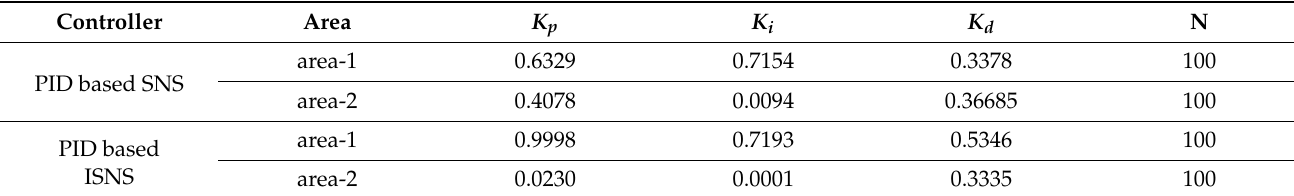
Table 2. The optimal parameters of the PID controller based on SNS and ISNS algorithms.